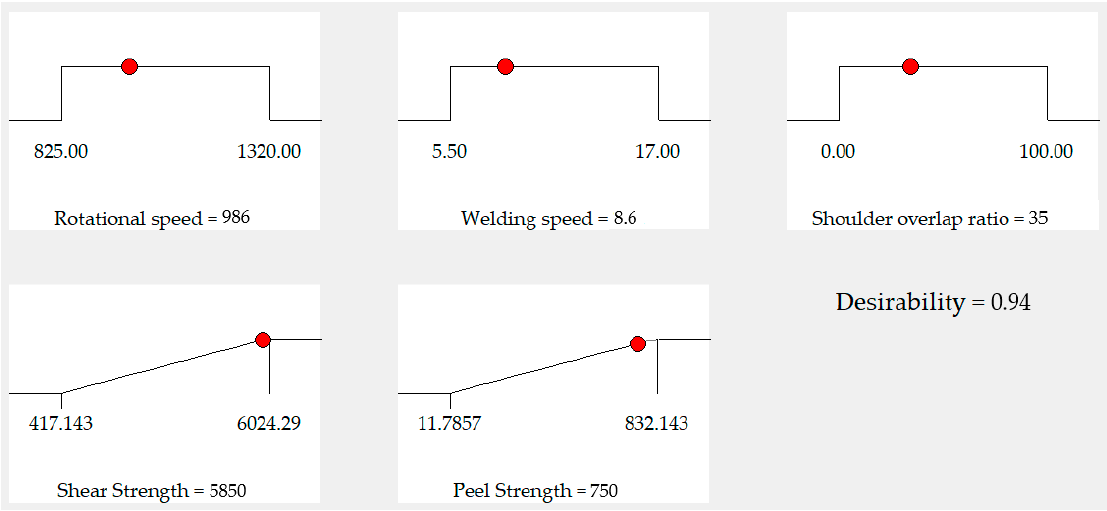
Figure 8. The desirability factor and the optimised process parameters.